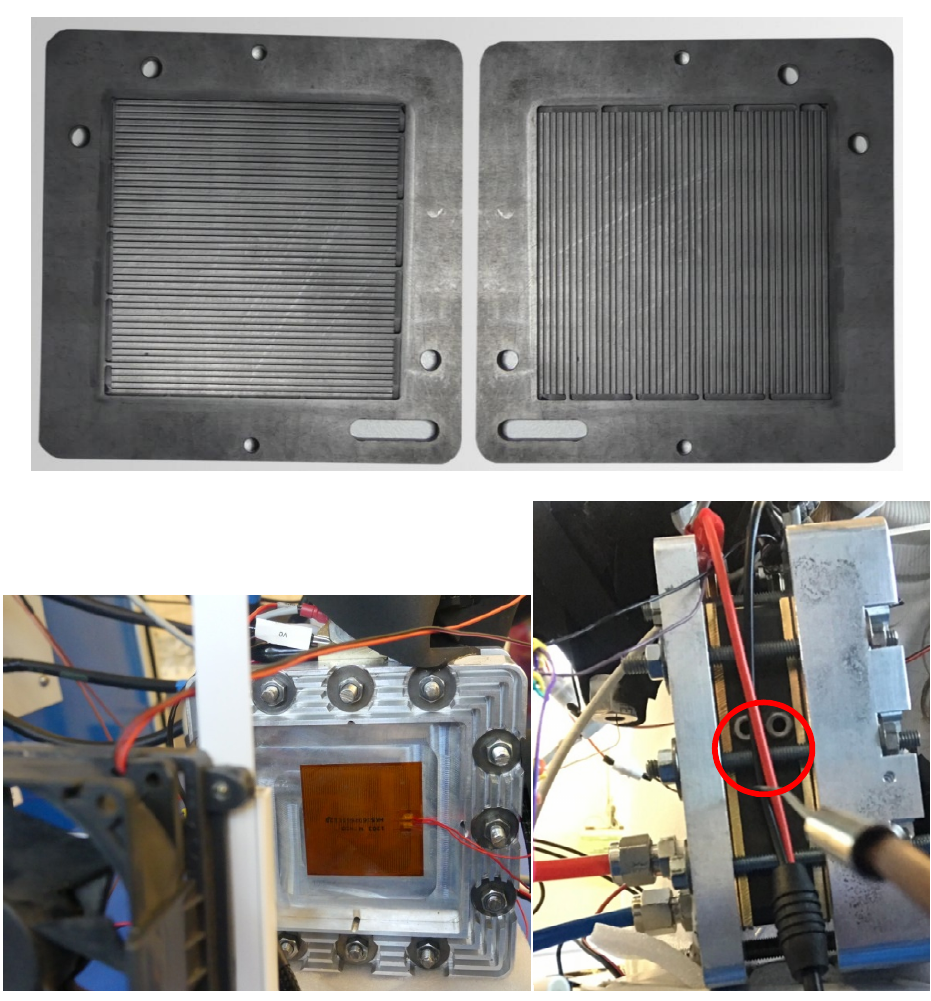
Figure 2. ( Top ) Graphite bipolar plates (anode side and cathode side) with serpentine flow field. ( Bottom left ) External fan (black) and film heater attached to the terminal plates for temperature control. ( Bottom right ) Thermocouple inserted into the cathode monopolar plate for cell temperature measurement.